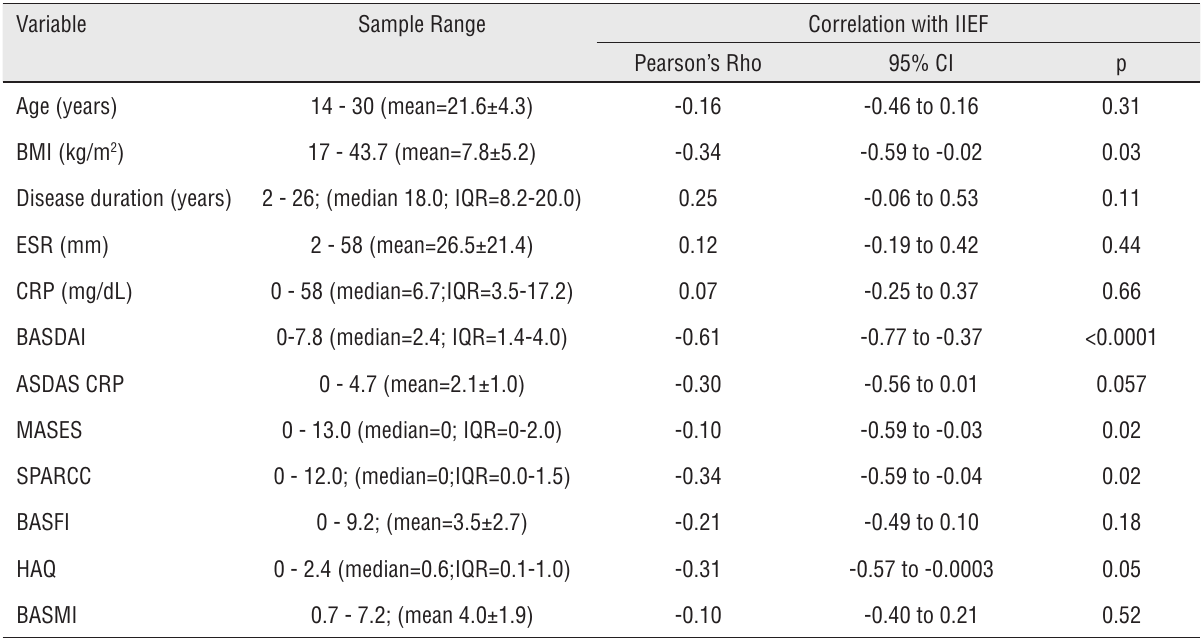
Table 4 - Data on clinical profile, inflammatory, functional and laboratory of Ankylosing spondylitis patients and its correlation with IIEf (International Index of Erectile